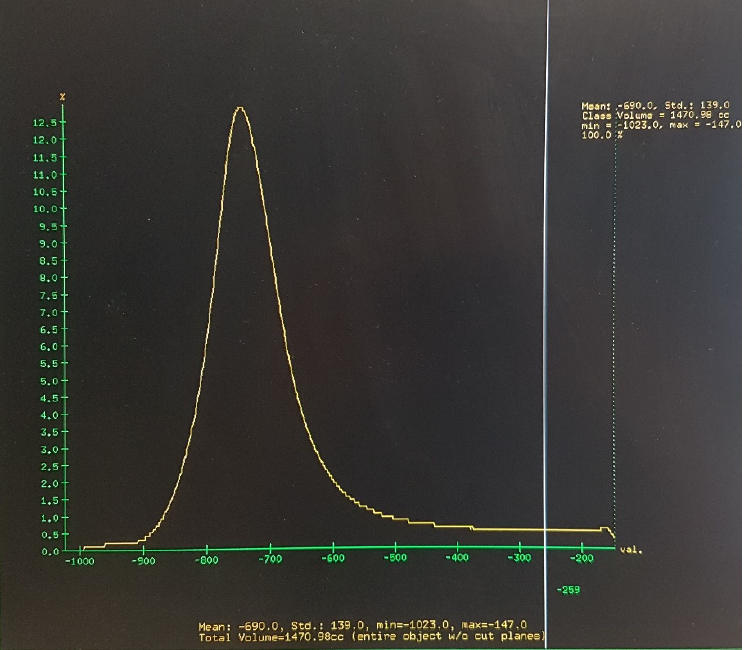
Figure 2. The total lung and airways volume, as well as the minimum attenuation value, maximum attenuation value, and the mean and standard deviation of attenuation values of all voxels included in the images of lung parenchyma and central airways were automatically provided by the software.